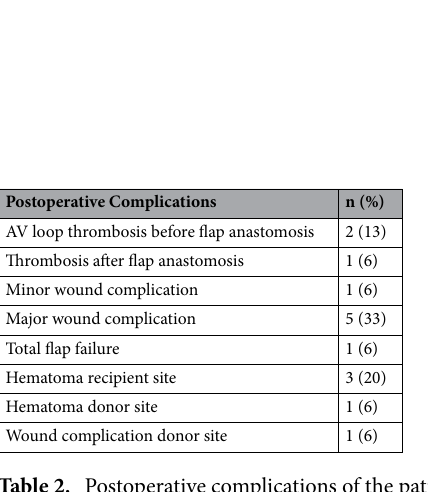
Table 2. Postoperative complications of the patients. AV